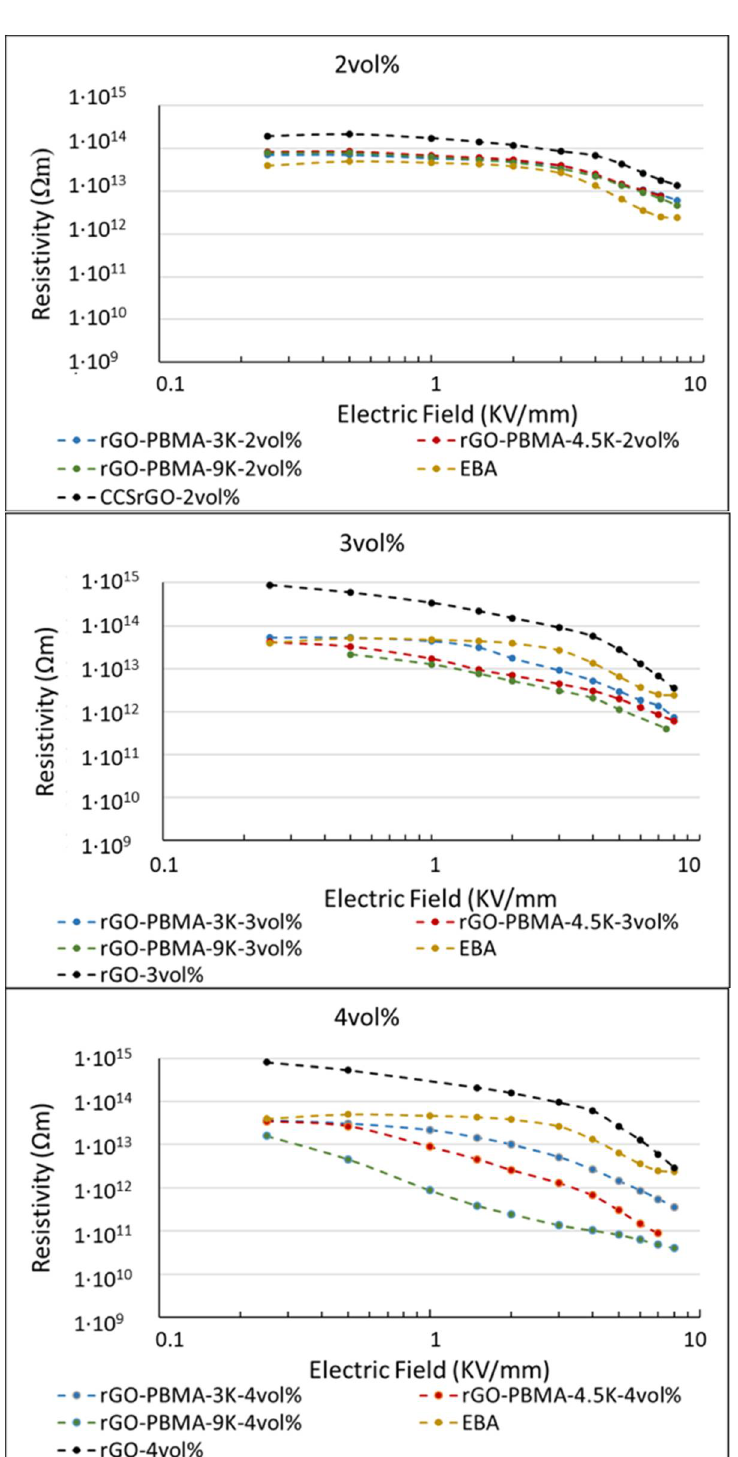
Figure 5. Resistivity measurements for the 2, 3, and 4 vol.% nanocomposites.